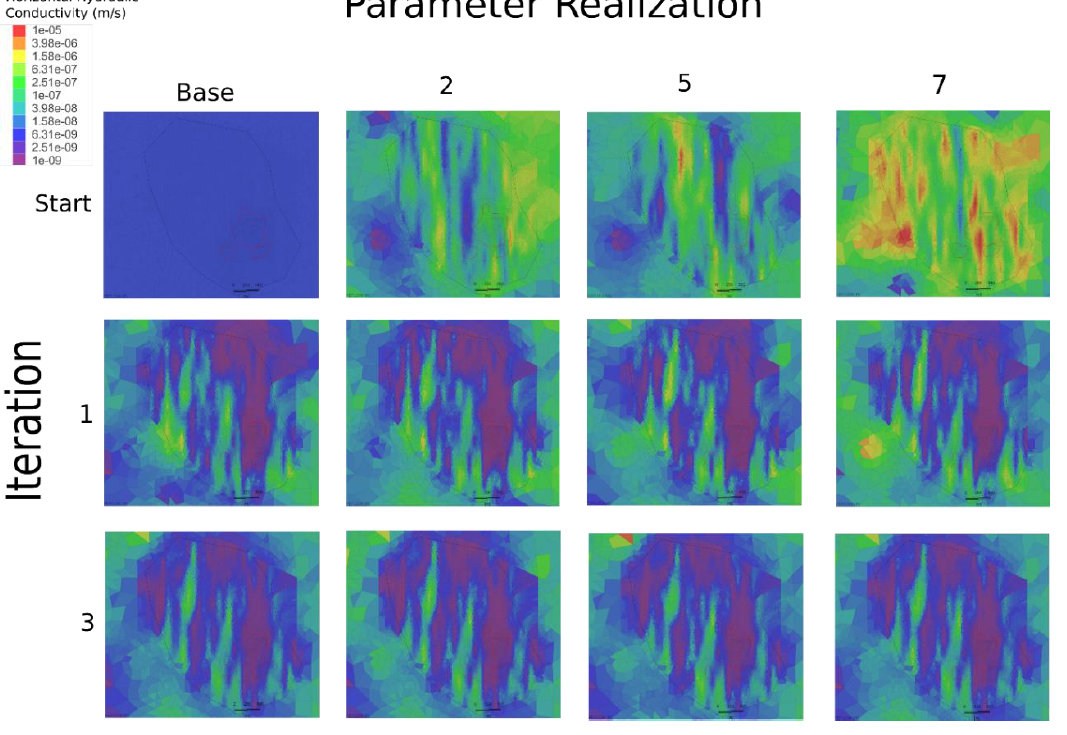
Figure 5. Horizontal hydraulic conductivity fields on a log scale over the local study area (LSA) shown in Figure 4 for the base and three selected realizations through the three calibration iterations. This shows the progression of parameter fields from the starting model and initial geostatistical fields to calibrated models displaying similar features through iterations one and three.